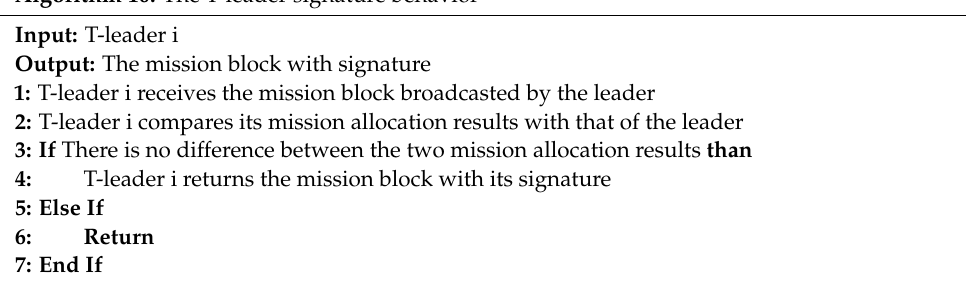
Algorithm 10. The T-leader signature